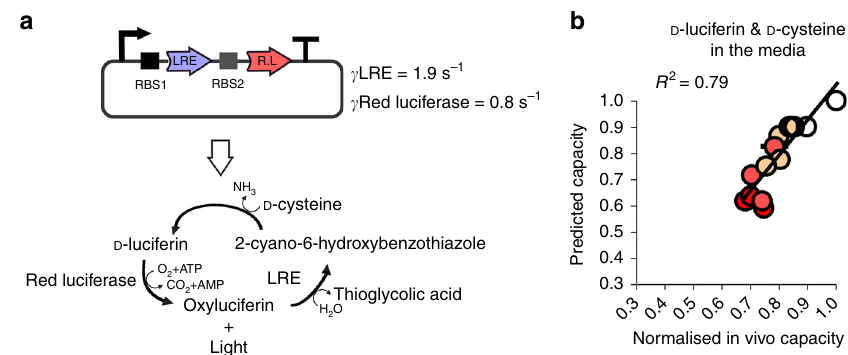
Fig. 3 Predicting the burden of operon designs for the Luciferase biosynthesis pathway. a Diagram of the luciferase pathway and the γ -values for the two enzyme-encoding sequences as measured by the cell lysate capacity assay (see Supplementary Fig. 5). The operon is designed with randomised RBS sequences and promoter BBa_J23100 (strong). b Model-predicted burden of each operon design compared to the measured capacity of E. coli expressing the operons. D -Luciferin and D -cysteine are added to the media to enable luminescence measurements and these are represented by the red intensity in each circle. Error bars show standard error of three independent repeats. Values are normalised to the capacity obtained with capacity monitor